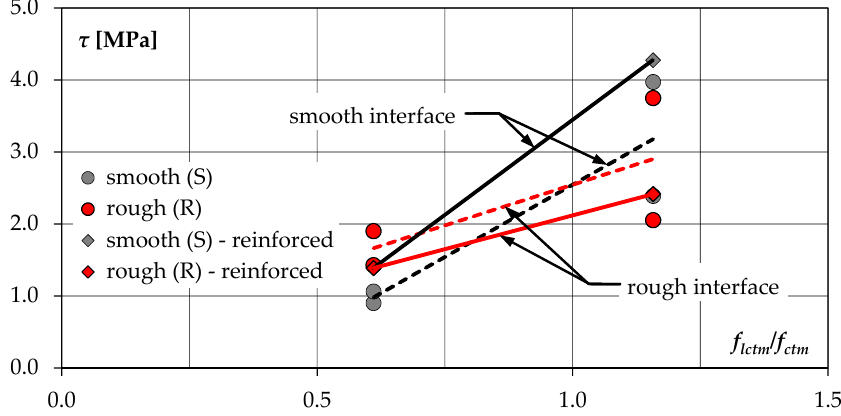
Figure 18. Relation between shear stress at peak load and concrete tensile strength ratio (solid lines—specimens with shear reinforcement, dashed lines—specimens without reinforcement).